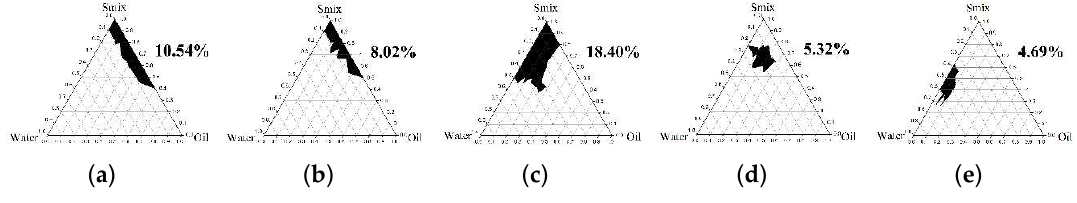
Figure 6 . Pseudoternary phase diagram of CA / Tween 85 and propylene glycol / water, when the Smix ratio was ( a ) 6 : 1; ( b ) 4 : 1; ( c ) 2 : 1; ( d ) 1 : 1; ( e ) 1 : 2 . The dark area represents the microemulsion region .